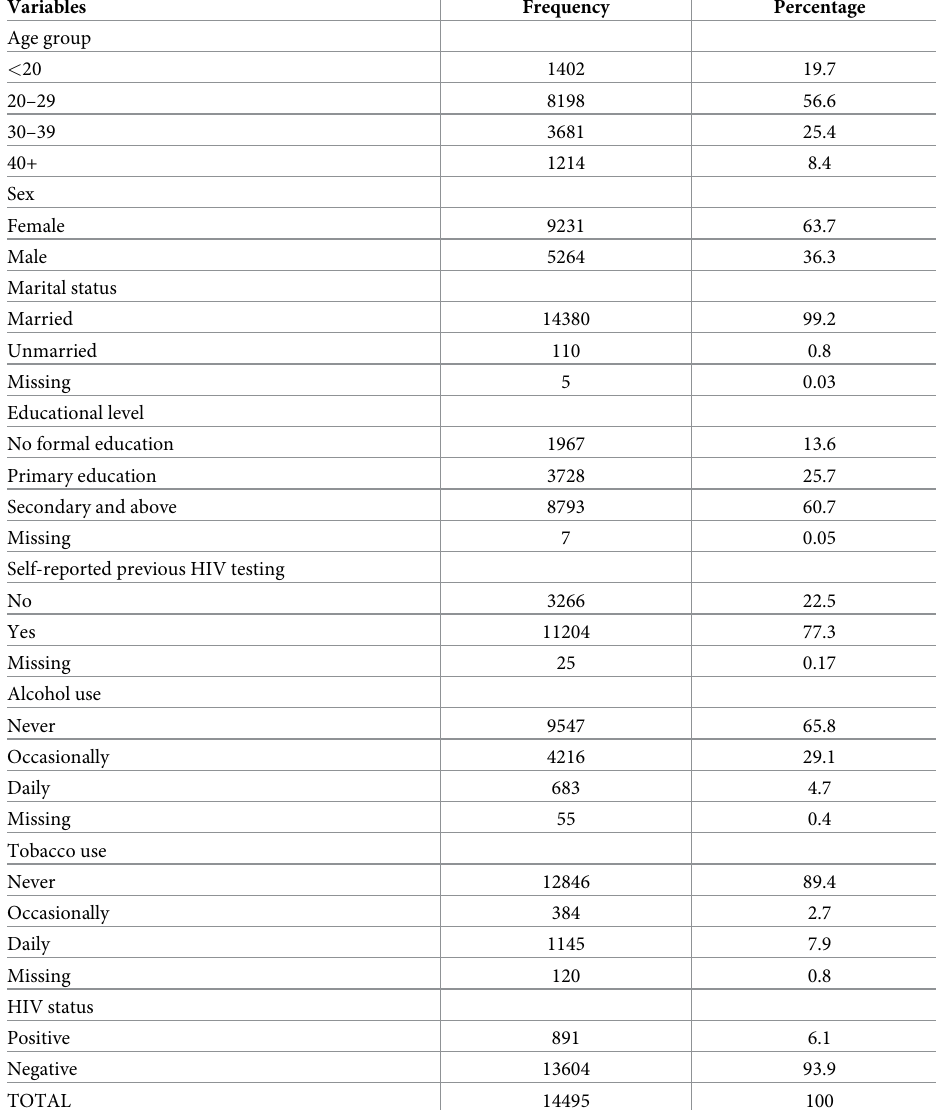
Table 1. Characteristics of female and male HBI participants in Benue State, Nigeria.